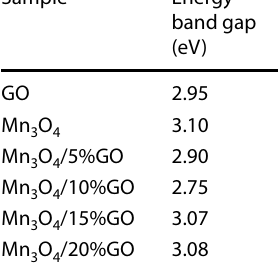
Table 4 Energy gaps of Mn linear portion of Tauc plots of the UV-visible absorptions of each